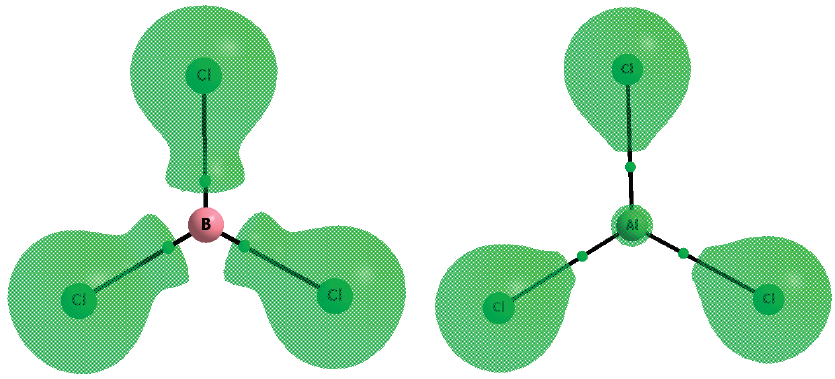
Figure 6. The molecular graphs of the BCl 3 ( left ) and AlCl 3 ( right ) molecules; solid lines correspond to bond paths, big circles to attractors and small green circles to BCPs, the reactive surfaces (  2 ρ (r) = 0 isosurfaces) for these molecules are presented; results of the MP2/aug-cc-pVTZ